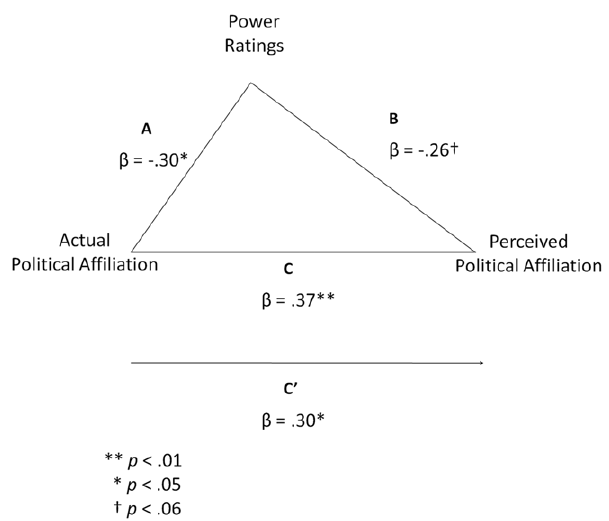
Figure 5. Mediation model with standardized regression coeffi- cients showing the influence of participants’ perceptions of Power as a partial mediator of the relationship between targets’ actual political affiliations (coded as Republican =0, Demo- crat =1) and perceived political affiliations (coded as the percentage of participants who rated each target as a